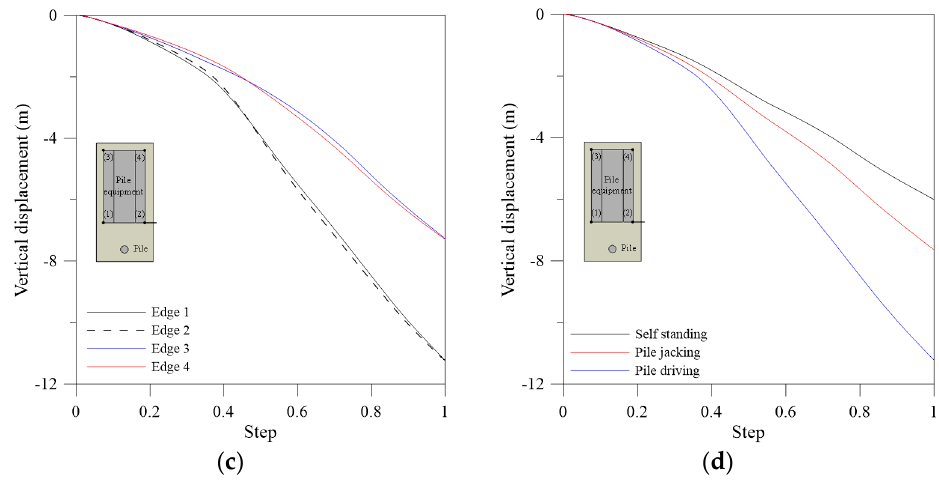
Figure 15. Vertical displacement with edges of pile equipment: ( a ) Self-standing of pile equipment; ( b ) pile jacking; ( c ) pile driving; and ( d ) comparison with methods of pile installation.